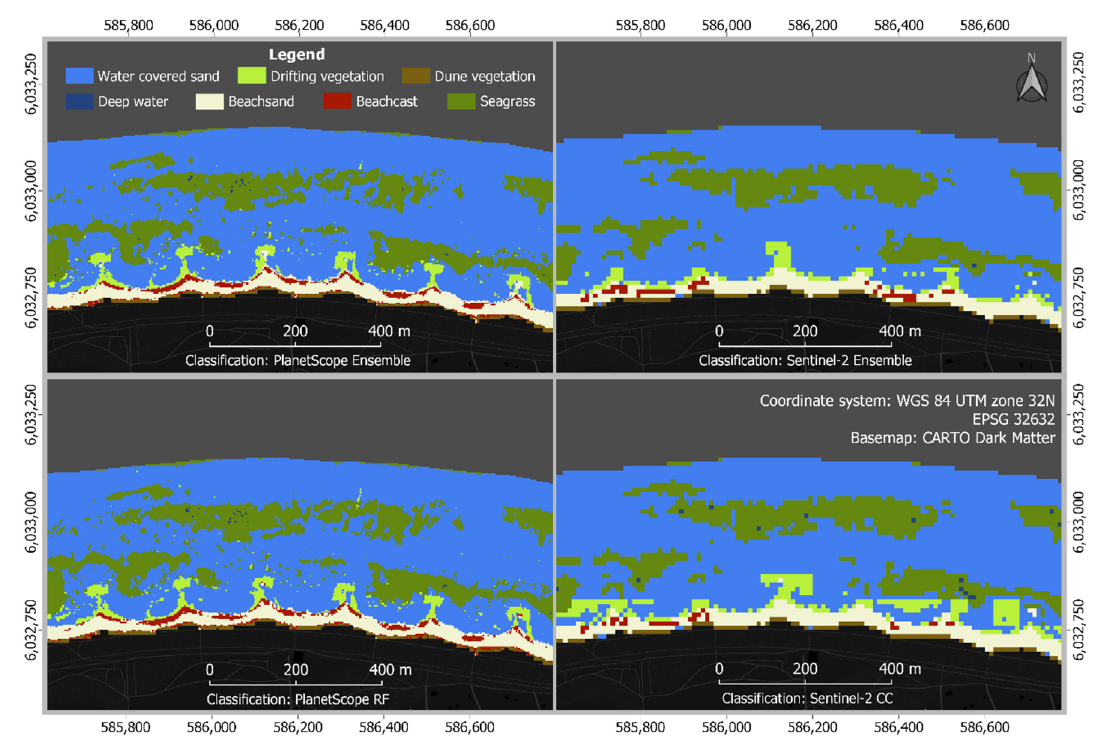
Figure 6. Comparison of the four best classification results for PS and S-2.